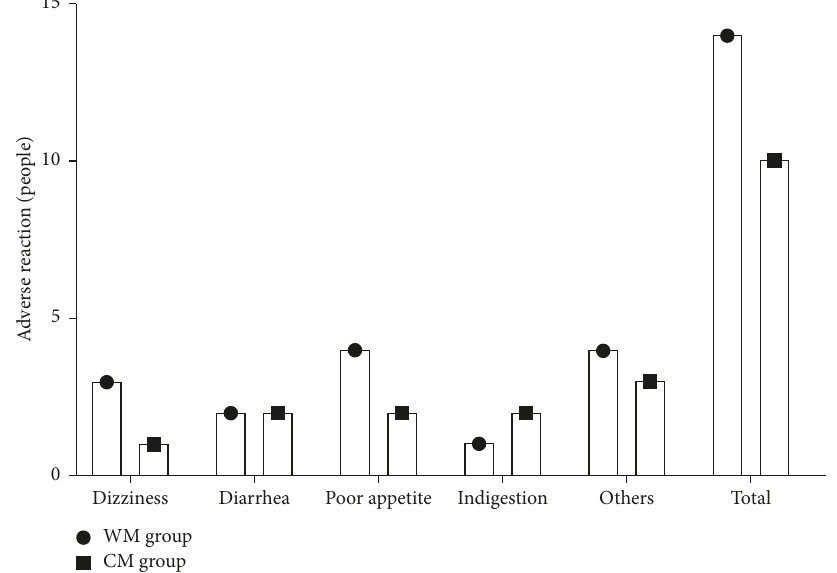
Figure 7: Comparison of adverse effects in two